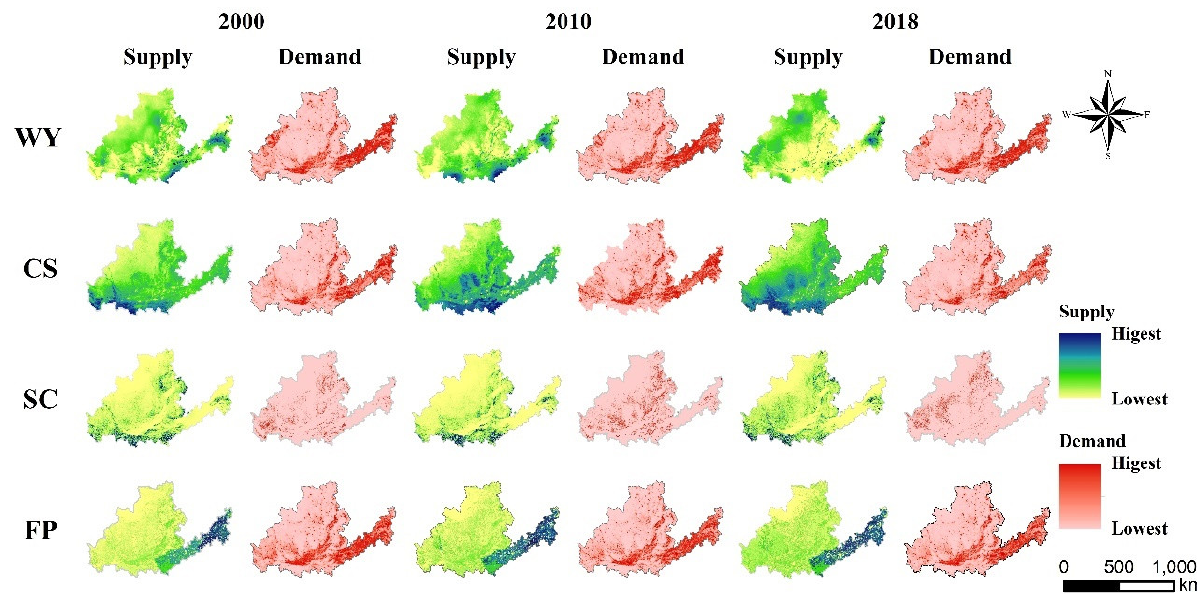
Figure 4. Spatial pattern of supply and demand for individual ecosystem services (ES) in the Yellow River Basin in 2000, 2008, and 2018. ES indicators are: WY—water yield; CS—carbon sequestration; SC—soil conservation; GP—grain production.